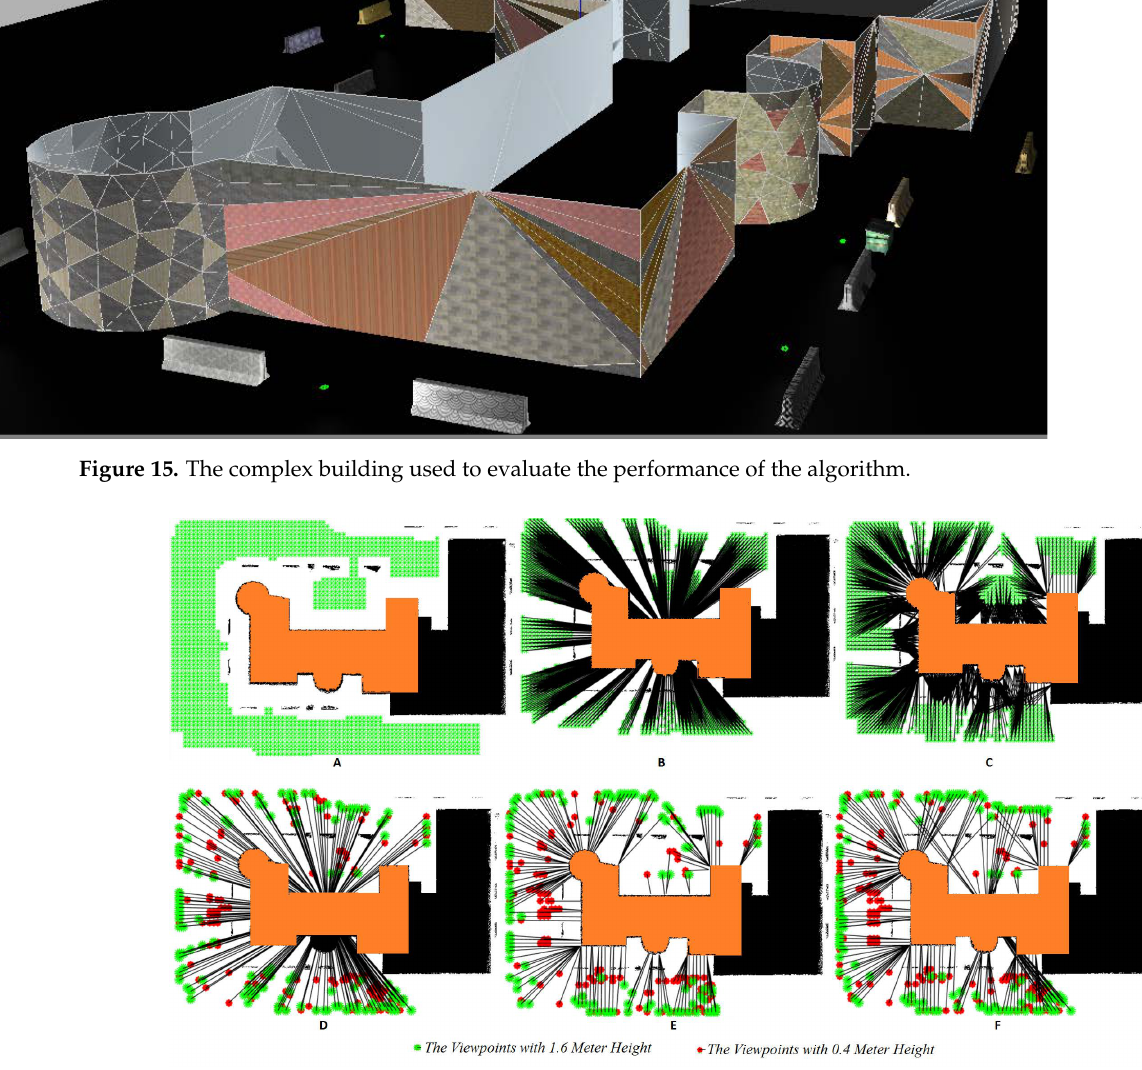
Figure 16. The steps of centre, façade, and hybrid pointing approaches for the imaging network design of complex buildings. The buffer of optimum camera positions ( A ); the viewpoint directions toward the centre of the building ( B ) and toward the façade ( C ); the outputs of the clustering and selection approach on centre pointing viewpoints ( D ); façade pointing viewpoints ( E ) and both of them ( F